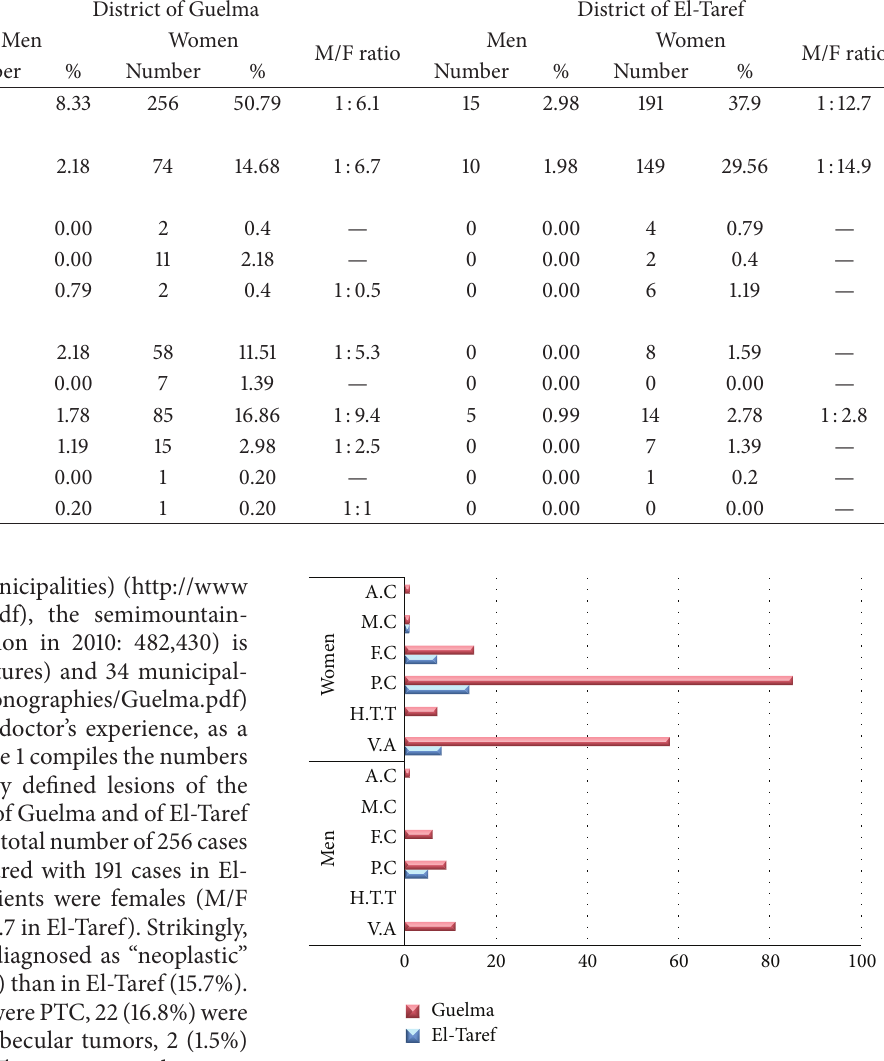
Figure 2: Distribution of different forms of neoplastic lesions of the thyroid in men and women in the districts of Guelma and of El- Taref. A.C: anaplastic carcinoma, M.C: medullary carcinoma, F.C: follicular carcinoma, P.C: papillary carcinoma, H.T.T: hyalinizing trabecular tumors, V.A: follicular